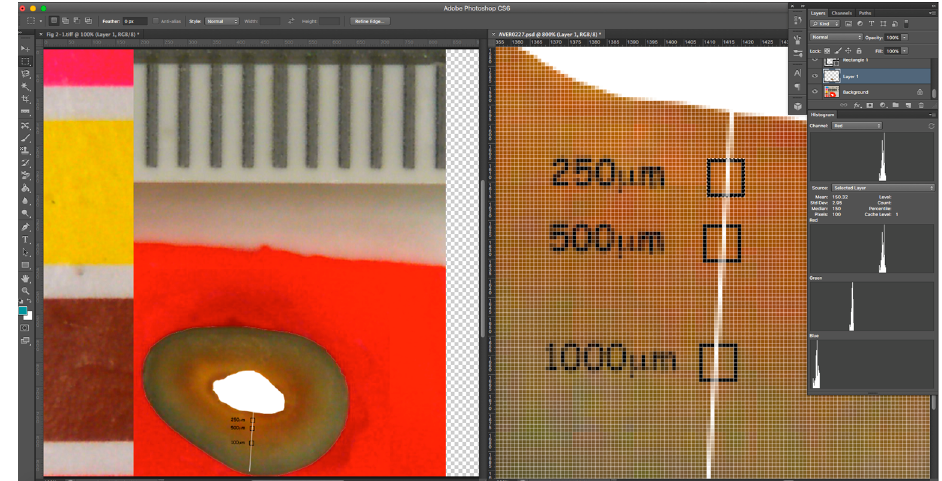
Figure 2. Screenshots showing the colour analysis method. In the example shown, the stained root had been treated with Calmix for 3 weeks. The right panel shows an 800% magnification of part of the left image. A white line was placed to ensure reproducible areas were elected between prospective images of the same root over time. Sample areas were taken at designated distances from the canal wall, as shown in the right panel. A total of 100 pixels in a 10 × 10 pixel selection area (annotated with a black square) were used for analysis, using the histogram tool.